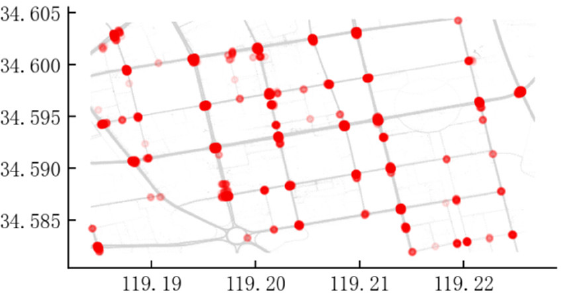
Figure 11. Scatter of intersection points.